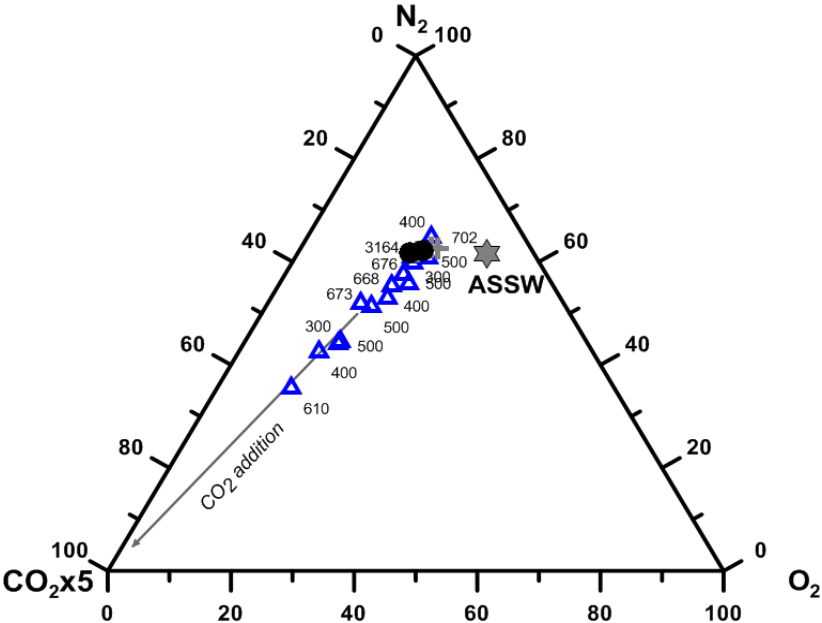
Figure 6. O -N -CO ternary diagram. The samples plot on a straight mixing line between 2 2 2 atmospheric components O and N and CO typically of magmatic/hydrothermal origin 2 2 2 The Air Saturated Sea Water mark (grey star, ASSW) indicates where dissolved gases in ASSW (air-saturated sea water) sea water plot. Blue triangles = samples from above the area marked by physical anomalies (see text); grey crosses = samples from a tow-yow across the seamount; black filled circles = samples from a vertical cast over the Tyrrhenian batial plain. The numbers indicate the sampling depths.